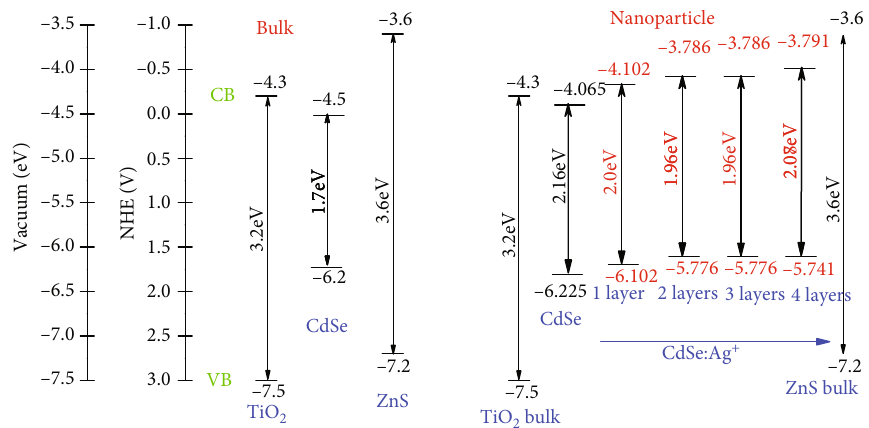
Figure 4: A schematic diagram for the band alignment in bulk materials and TiO